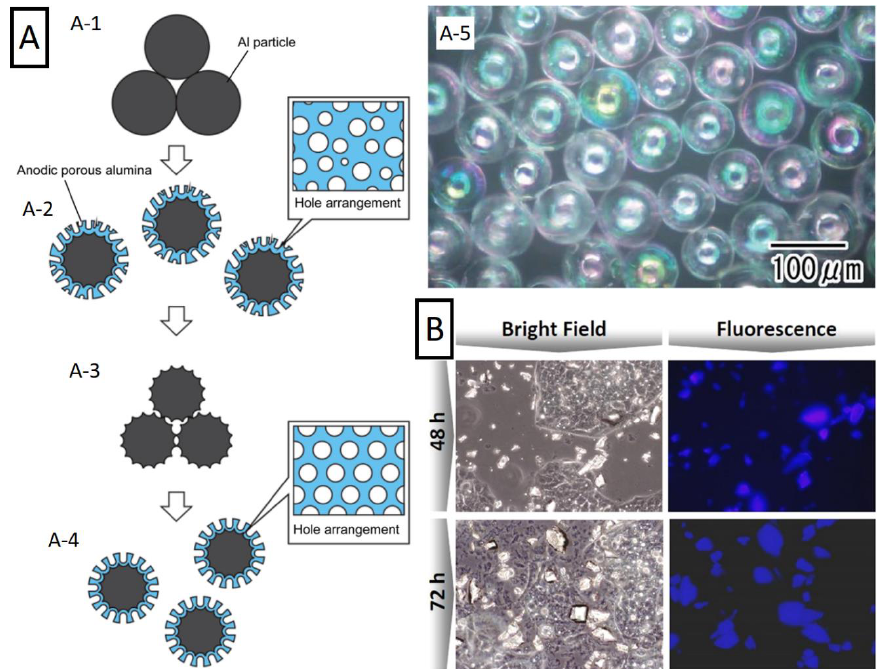
Figure 10. Nanoparticles based on NAA. ( A ) ( A-1 – A-4 ) Schematic of the multi-step formation process of nanoporous anodic spheres and ( A-5 ) optical microscope image of hollow spheres made of porous alumina obtained by removal of aluminum residues. Reprinted (adapted) with permission from [173]. Copyright 2018 The Royal Society of Chemistry. ( B ) Microscope images of HepG2 cells incubated with intrinsically photoluminescent nanoporous alumina particles obtained